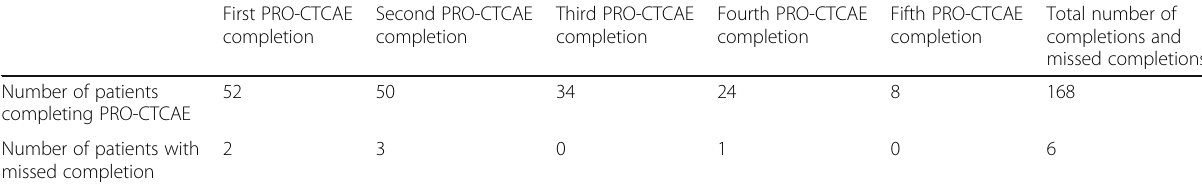
Table 2 Number of patients completing